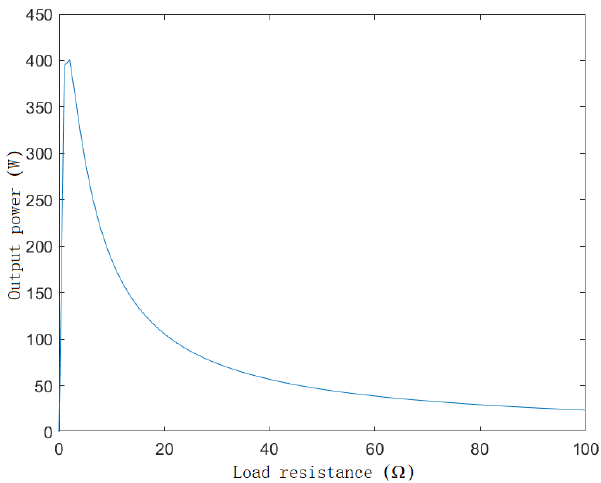
Figure 12. Relationship between output power and load resistance under the three coils.